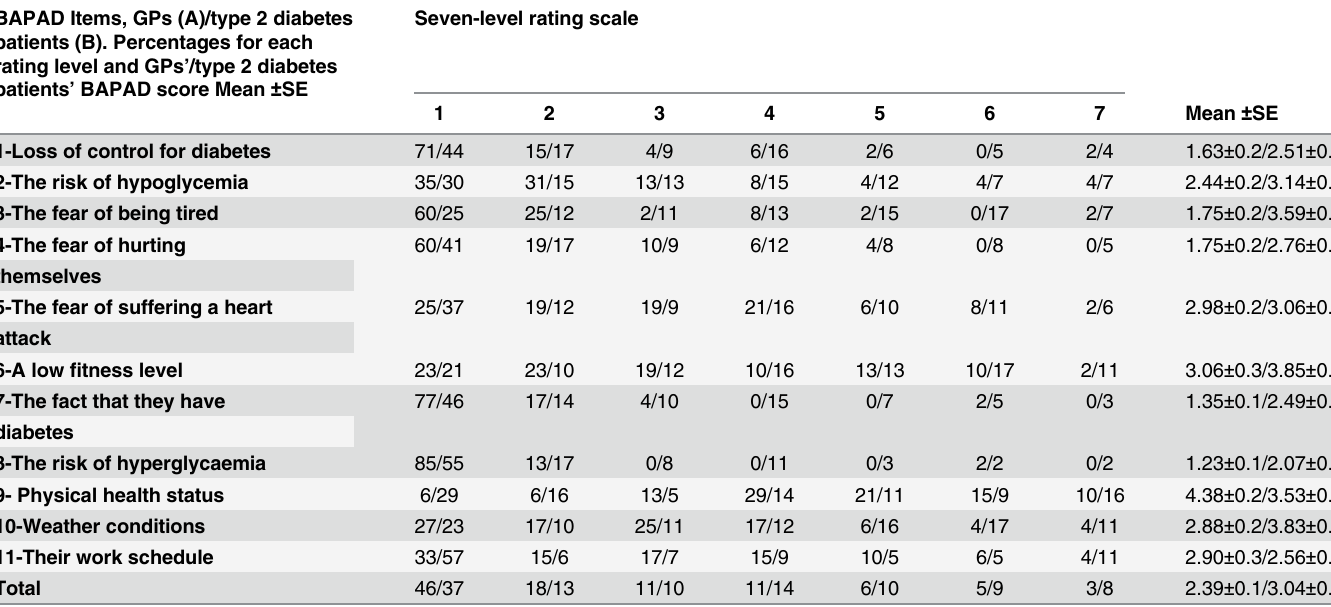
A: For GPs: “ Indicate the likelihood that each of the 11 items would keep you from prescribing regular physical activity during the next 6 months to your type 2 diabetes patients. ” B: For type 2 diabetes patients: “ Indicate the likelihood that each of the 11 items would keep you from practicing regular physical activity during the next 6 months. ” (Ranging from 1 = very unlikely, 2 = unlikely, 3 = rather unlikely, 4 = uncertain, 5 = rather likely, 6 = likely, 7 = very